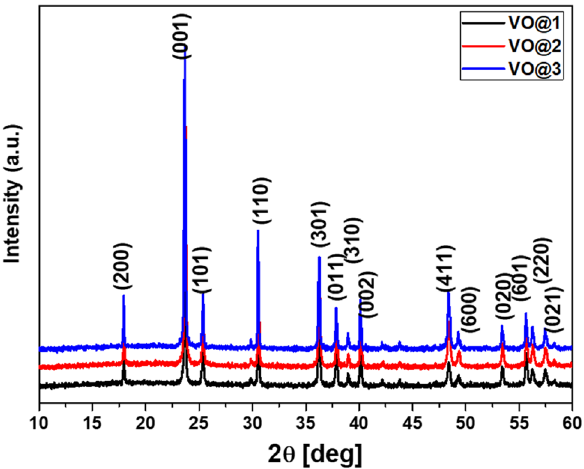
Figure 2. The XRD pattern of V 2 O 5 powders obtained via modified sol–gel method using citric acid as the main chelating agent ( VO@1 ) with: acetic acid ( VO@2 ), ethylene glycol ( VO@3 ) as the second chelating agent.